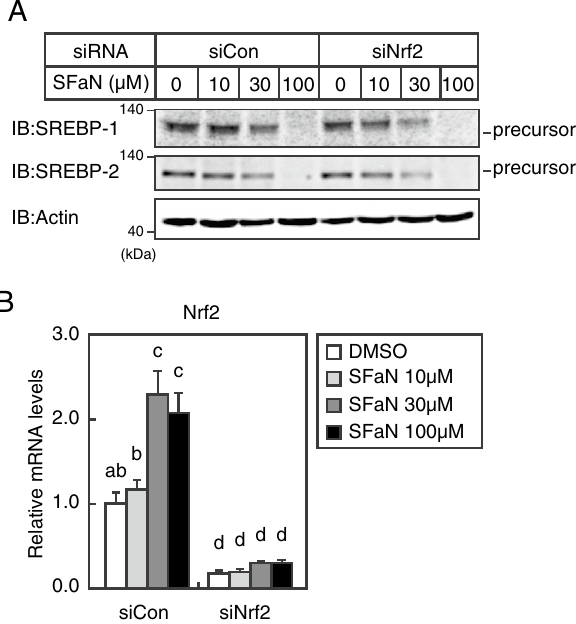
Figure 10. SFaN promotes the Keap1-Nrf2 pathway-independent SREBP precursor degradation. ( A , B ) Huh-7 cells were transfected with 24 pmol of siRNA (siCon) or Nrf2 siRNA and incubated in medium B for 48 h. The cells were then shifted into medium B in the presence of the vehicle or the indicated concentrations of SFaN for 3 h. Whole-cell extracts underwent immunoblotting (IB) with anti-SREBP-1 (2A4), anti-SREBP-2, or anti-β- actin antibodies ( A ). The asterisk denotes nonspecific bands. Full-length images are presented in Supplementary Fig. S10. Total RNA was isolated from the cells. Real-time quantitative PCR was performed, and relative mRNA levels were obtained by normalization to GAPDH mRNA. All data are represented as the mean ± S.E. (n = 3) ( B ). Different superscript letters denote statistical significance (p <